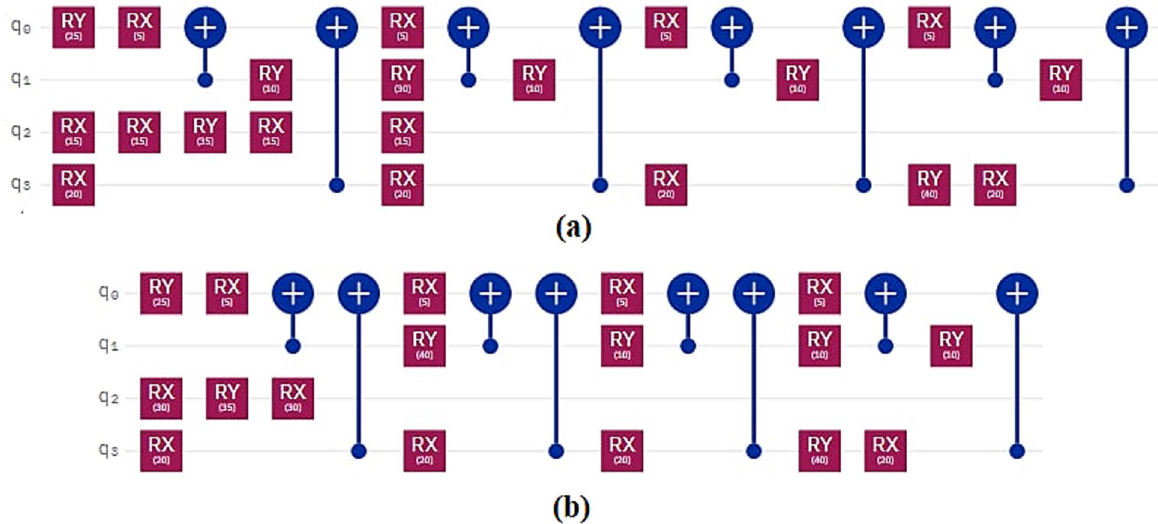
Figure 8. Demonstration of original and improved quantum transfer learning circuits. Diagram ( a ) shows the non-optimal circuit and diagram ( b ) shows the improved circuit with reducing the number of gates by 10.7%.